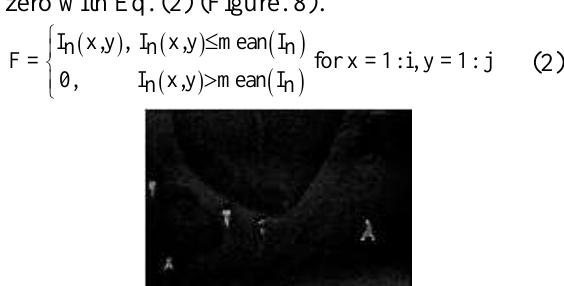
Figure 8. Adjustment of normalized thermal